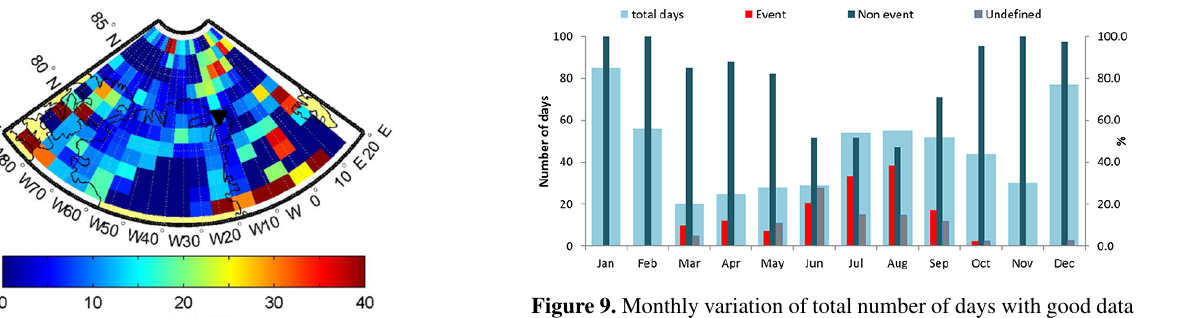
Figure 9. Monthly variation of total number of days with good data (left vertical axis) and frequency percentages (%) of event days, non-event days and undefined days (right vertical axis) during the study period (July 2010–February